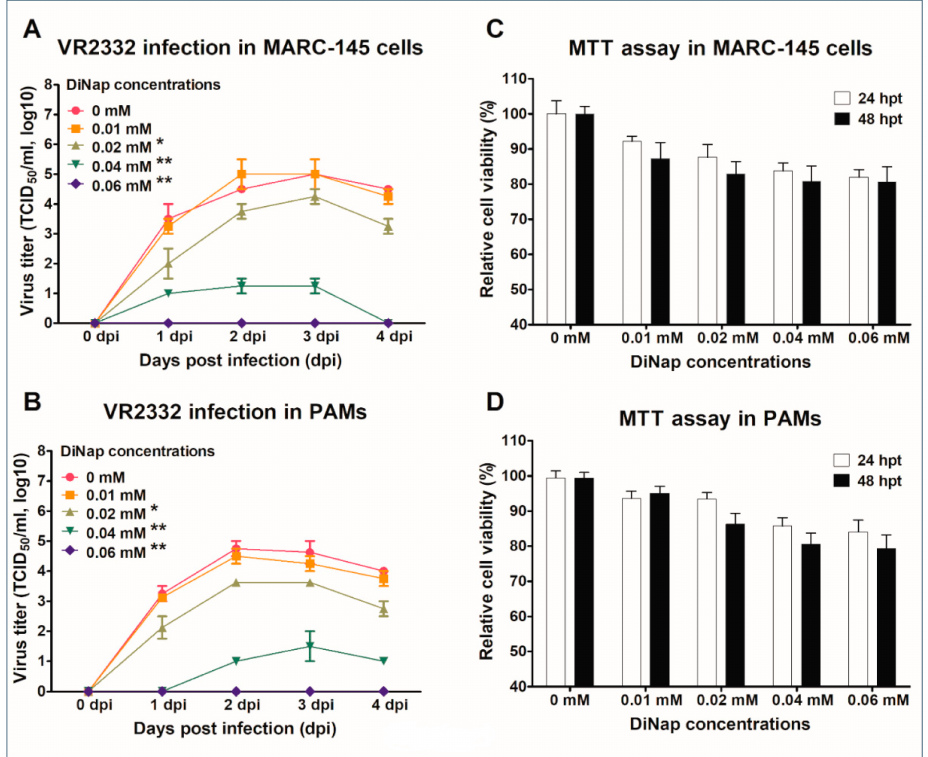
Figure 1. Evaluation of the antiviral effect of DiNap on Porcine reproductive and respiratory syndrome virus (PRRSV) replication in cells. The antiviral activity of DiNap against the replication of